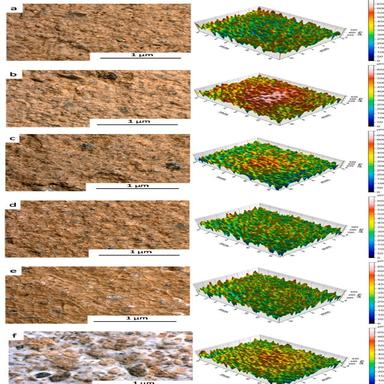
Microscopy images acquired via portable digital microscopy (left column) and 3D surface maps via confocal microscopy (right column) of earthen mock-ups. a) Untreated (CON), b) treated with KOH and c) BAC, d) consolidated with ES, e) NS, and f) NL.